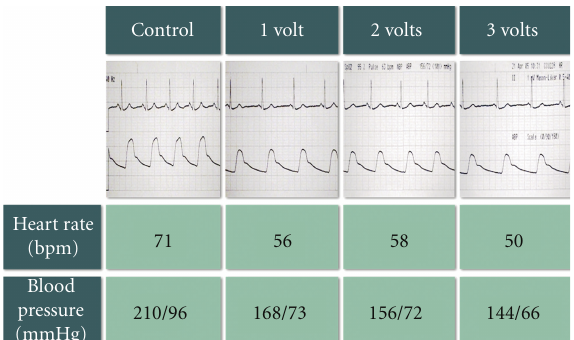
Figure 3: Blood pressure and heart rate reduction using barorecep- tor stimulation therapy (BST) from 1 to 3 volts. Note that acutely blood pressure was reduced from 210/96 to 144/66 and heart rate from 71 to 50 beats per minute. Figure 4: Sympathetic fibers, both e ff erent and a ff erent, are found in the adventitia of renal arteries. These fibers can be ablated using specialized catheters that deliver radiofrequency